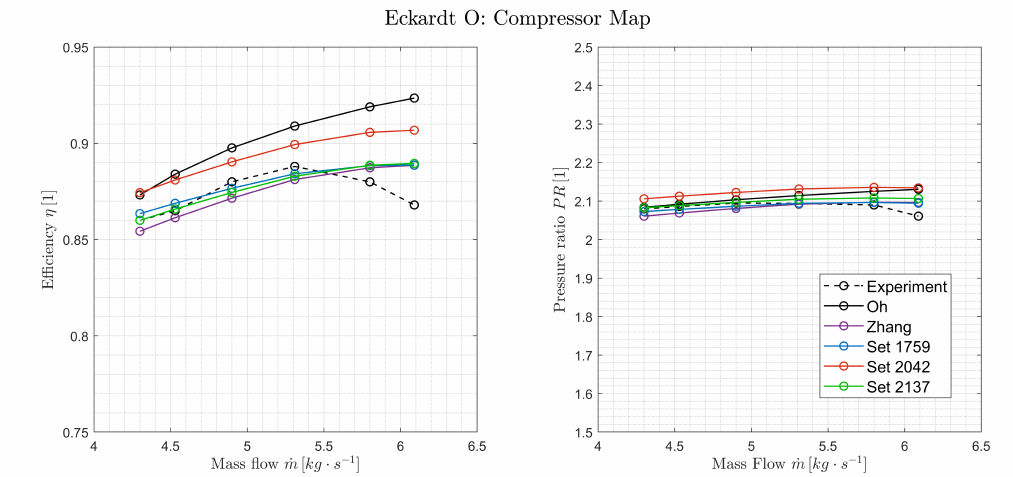
Figure 9. Eckardt O compressor map ( RPM = 14,000 min − 1 ) for chosen loss model sets in comparison to experimental data: ( left ) Efficiency; ( right ) pressure ratio.